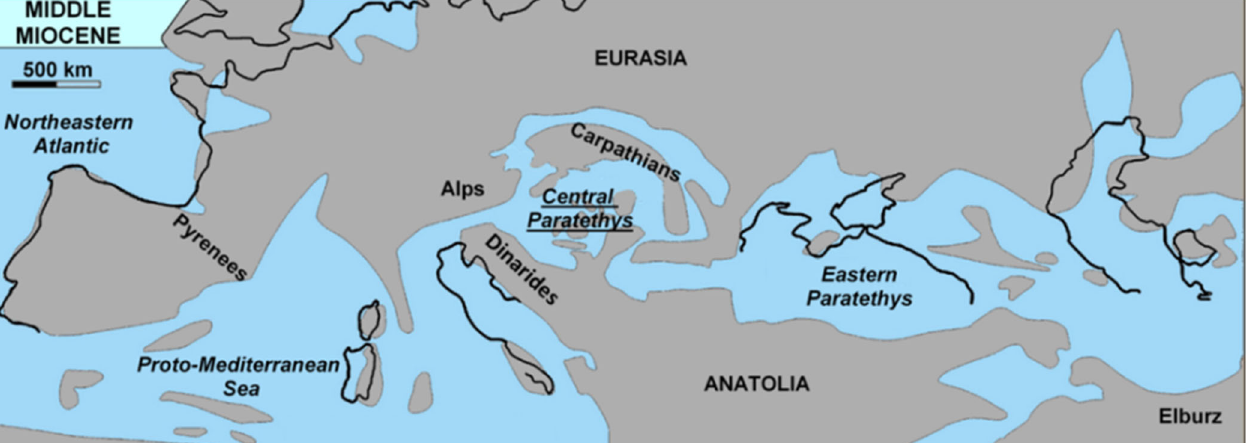
Figure 1. Simplified paleogeography of the Paratethys Sea during the Early to Middle Miocene (modified after [45]; original after [26,46]). Northern Croatia was a part of the Central Paratethys